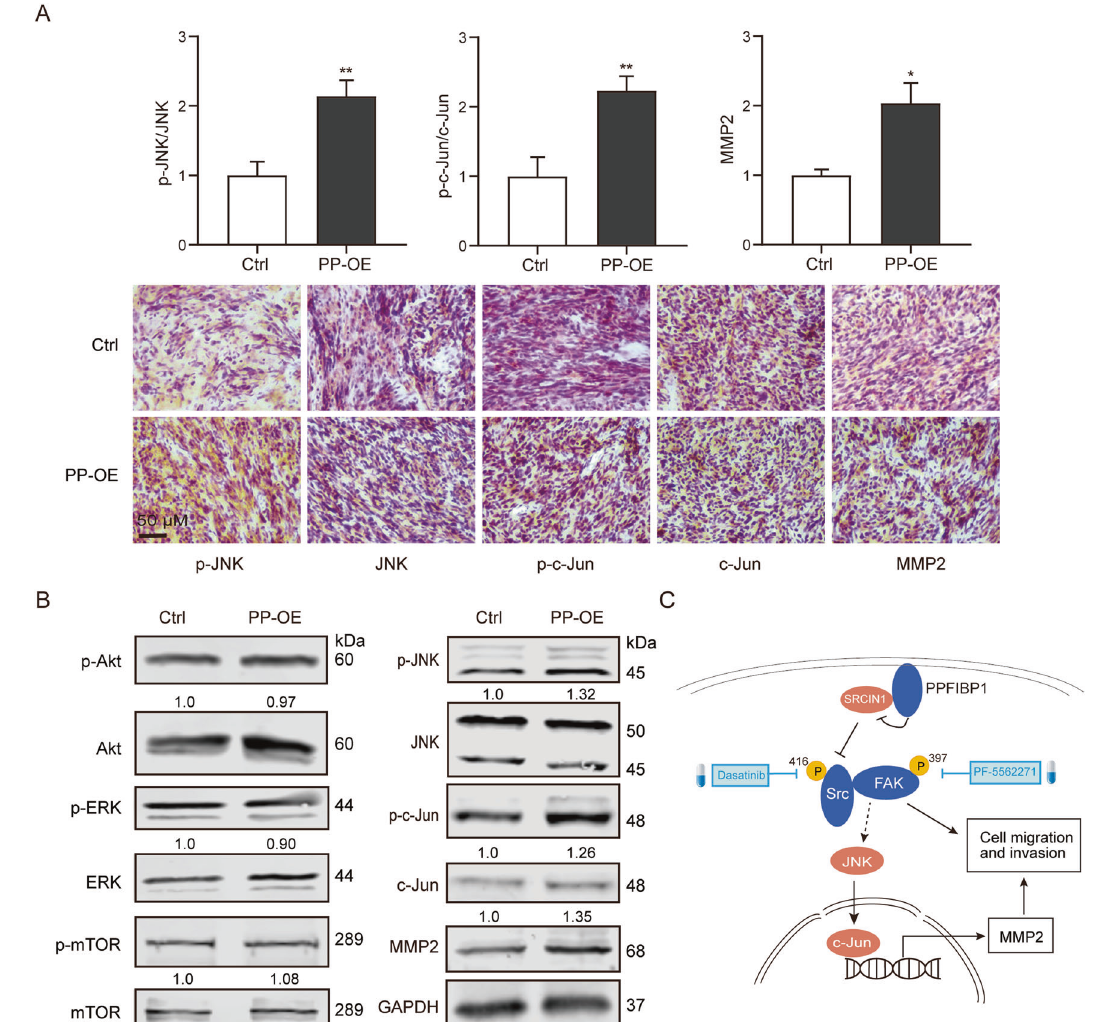
Fig. 7 PPFIBP1 may promote MMP-2 expression through activation of JNK and c-Jun. A Up: the expression of pY397 FAK, normalized to FAK, and the expression of pY416 Src, normalized to Src, and quanti fi cation of other indicated proteins normalized to GAPDH. Down: representative images of IHC analysis of indicated proteins in the intracranial tumors formed by U251 MG cells with PP-OE or the vector control. The fi gures are representative data from at least three independent experiments. B Western blot analysis of indicated proteins in PP- OE and the Ctrl glioma cells. The numbers represent the expression of phosphorylation proteins normalized to total proteins, or quanti fi cation of other indicated proteins, normalized to GAPDH. The fi gures are representative data from at least three independent experiments. C A schematic representation of the proposed pathway by which PPFIBP1 promotes cell migration and tumor invasion in GBM cells. The fi gures are representative data from at least three independent experiments. * P < 0.05, ** P <